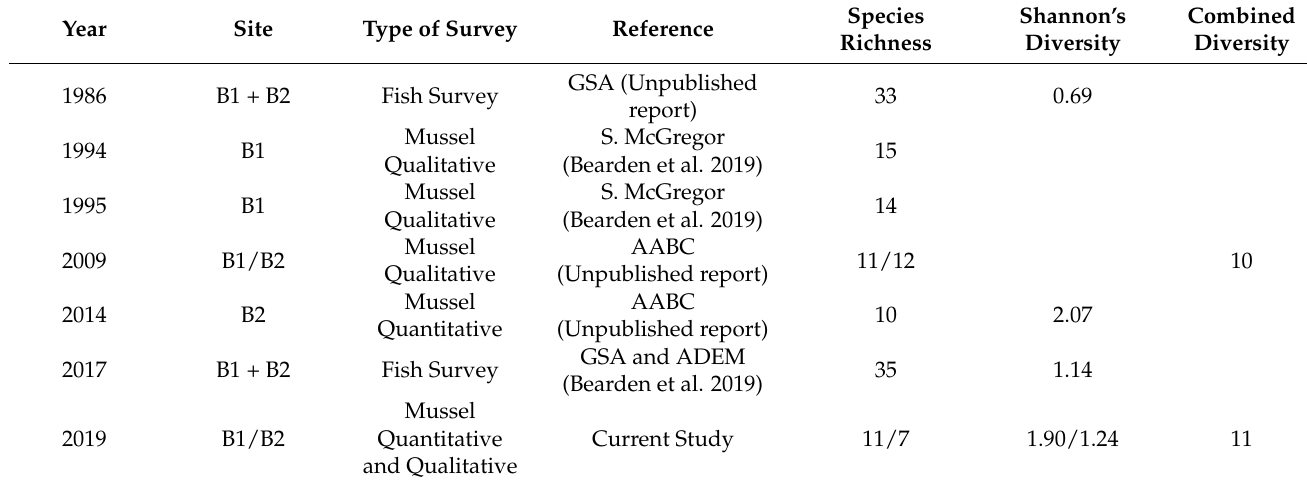
Table 1. Surveys conducted at B1 and B2 and the number of species